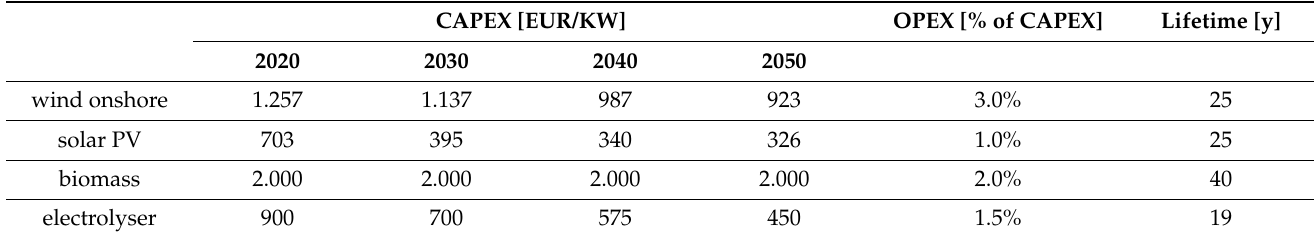
Table 1. Techno-economic assumptions for wind onshore, solar PV and biomass in TIAM. Source: [46–48]. CAPEX [EUR/KW] OPEX [% of CAPEX] Lifetime [y]